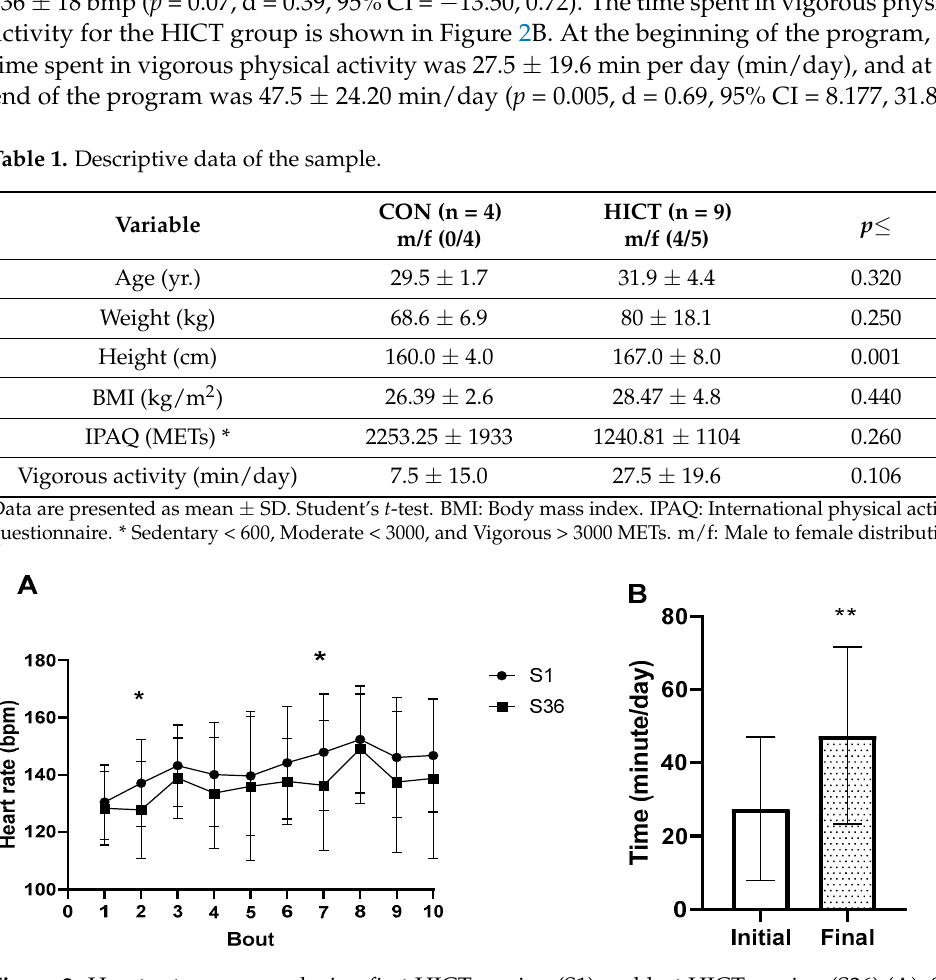
Figure 2. Heart rate response during first HICT session (S1) and last HICT session (S36) ( A ). Self- reported time spent with vigorous physical activity for HICT group ( B ). Student’s t -test, * p < 0.05, ** p <